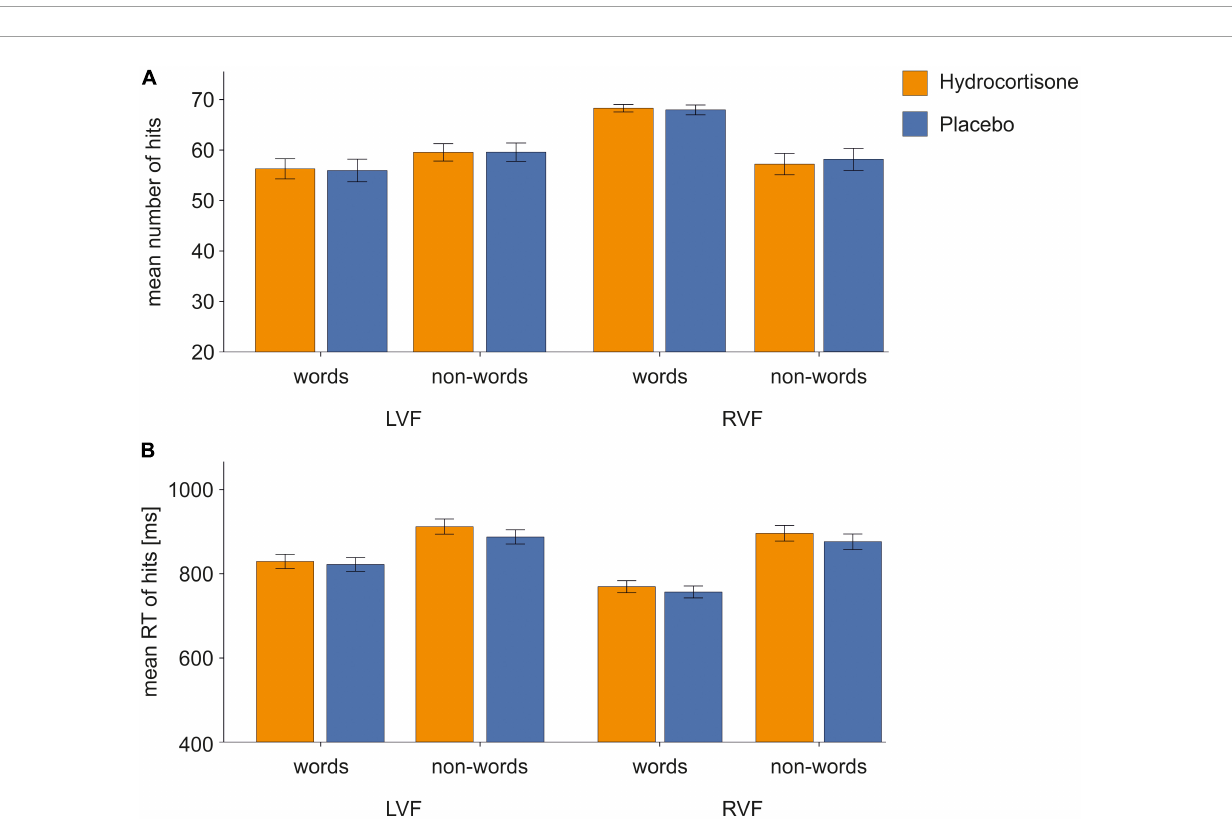
FIGURE3 Behavioral data of correct responses in the lexical decision task. Error bars represent 1 ± SEM. For words, we found more correct responses and faster reaction times to stimuli presented in the right visual field indicating typical left-hemispheric dominance for language processing. There were no effects of hydrocortisone administration. (A) Number of correct responses and (B) reaction times of correct responses in the